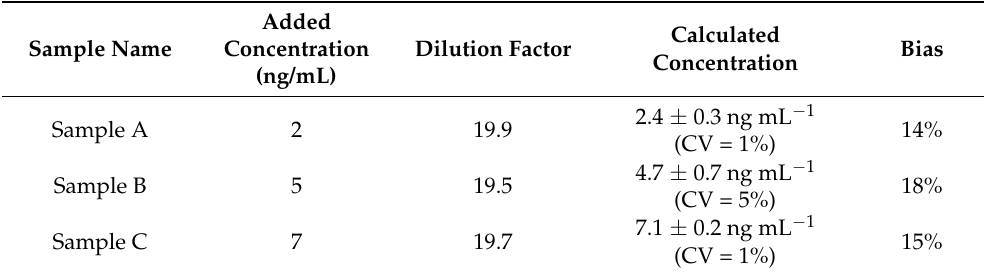
Table 3. Data obtained from the analysis of three saliva samples (corresponding to three aliquots of PSS spiked with different cortisol) by